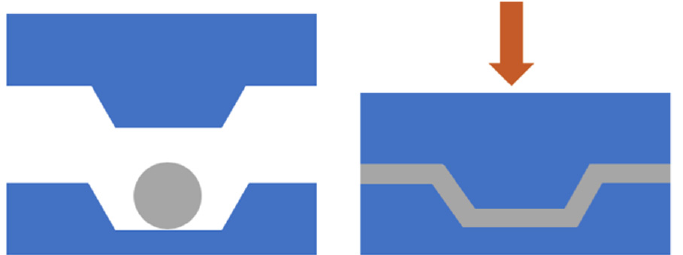
Figure 2. Schematic of the compression molding thermoplastic forming method.